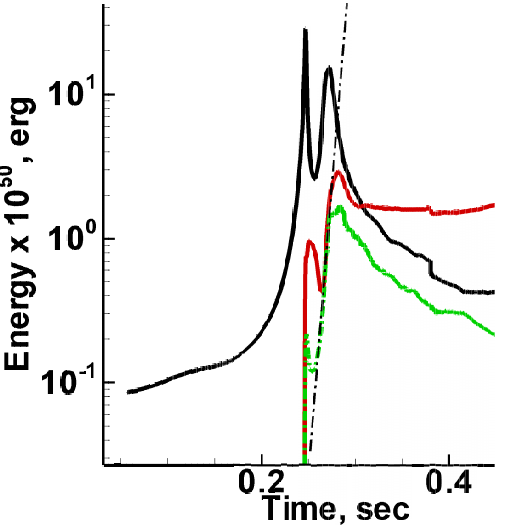
Figure 11: Zoomed time evolution of rotational energy E rot (solid line), magnetic poloidal energy E magpol (dashed line) and magnetic toroidal en- ergy E magtor (dash-dotted line) for the case H 0 = 10 9 G , E rot 0 /E grav 0 = 1%. Straight dash-dotted line shows exponential growth of the toroidal and poloidal magnetic